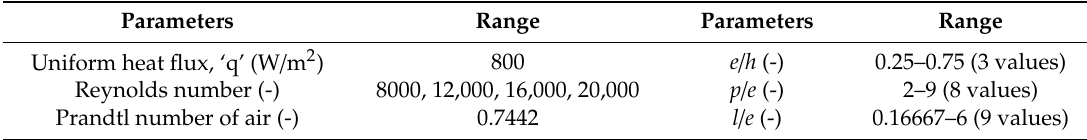
Table 2. Range of operating parameters for computational